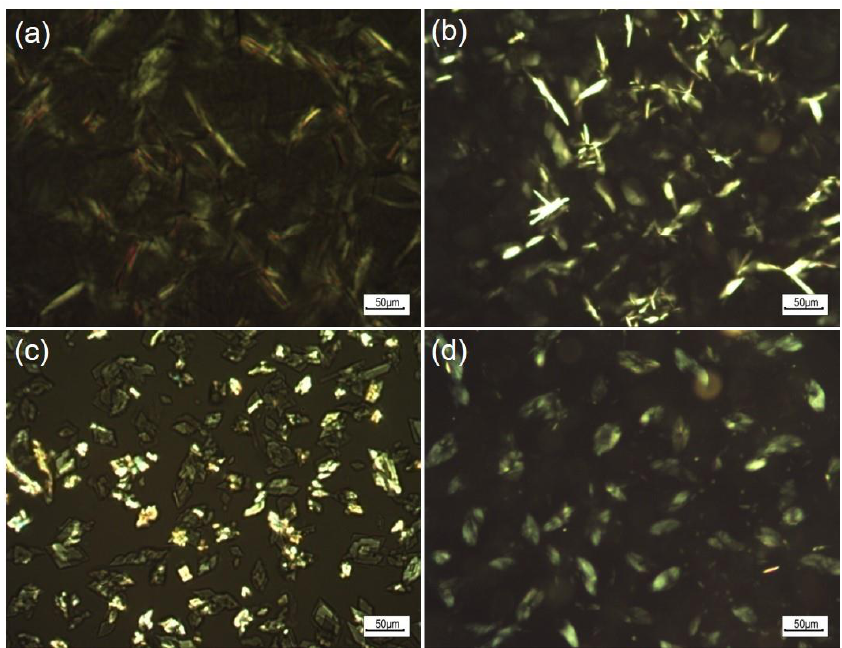
Figure 6. The polarized optical microscope images of the 15 wt% model oil in the ( a ) untreated ( b ) 500 mg·kg − 1 PM18; ( c ) 300 mg·kg − 1 PM18/SiO 2 ; ( d ) 300 mg·kg − 1 PM18-g-NSiO 2